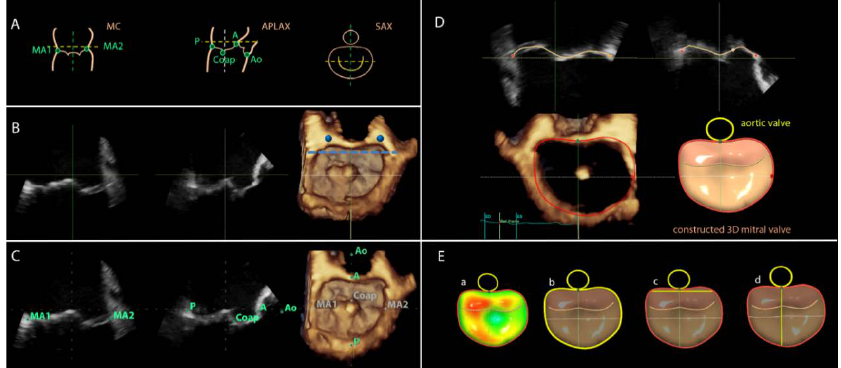
Figure 1. Overview of work flow of the 3D transesophageal echocardiographic semi-automated software of 4D Auto MVQ. ( A ) Graphical illustration of alignment and landmark placing. ( B ) Using the multiplanar reformation planes, the guidelines are aligned parallel to the 2D mitral annulus hinges in the mitral commissural view (MC) and the apical long axis view (APLAX). In the short axis view (SAX), the mitral annulus is shown in 3D. The trigones (marked in blue) are identified by moving the horizontal guideline until it intersects at the aorto–mitral border. ( C ) Landmarks are placed in MC and APLAX with direct 3D visualization in SAX for review: A, anterior annulus; Ao, aortic valve; Coap, leaflet coaptation; P, posterior annulus; MA1, anterolateral mitral annulus; MA2, posteromedial mitral annulus. ( D ) The software automatically defines the perimeter of the mitral annulus. The contours are shown for review and for manual adjustment if needed. ( E ) The software provides annulus dimensions of the D-shaped annulus, which is displayed in a reconstructed 3D model. Highlighted in multicolor: a, area. Highlighted in yellow: b, circumference (perimeter); c, intertrigonal distance; d, septal–lateral